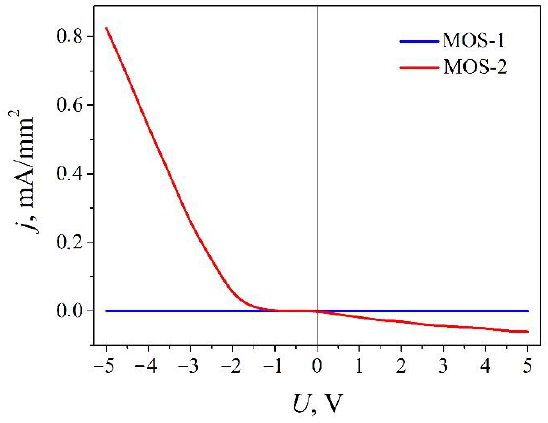
Figure 3. Current-voltage characteristics of the MOS structures. Photocurrent is induced when the MOS structures are exposed to the pulsed CO 2 laser light. In the case of “perfect” MOS-1 sample, photovoltage of negative polarity with respect to the grounded terminal is detected when reverse bias is applied (see measure- ment scheme in Figure 1), and the corresponding photocurrent maximum value increases sharply with the reverse bias and then saturates (Figure 4a, blue solid dots). Much weaker photosignal of opposite polarity (blue open dots) is observed under the forward bias. Typ- ical photocurrent pulse through the MOS-1 sample is shown in Figure 4b. Its dual-polarity shape is similar to an inherent feature of a charging-discharging capacitor. Comparison of curves of MOS-1 in Figures 2 and 4a implies that the photocurrent is most probably related to the capacitance of the structure. The main noteworthy difference in the course of these two dependencies is higher reverse voltage values at which saturation of the C-V charac- teristic begins. Most of the bias voltage applied on the MOS structure falls on the insulator, and the only capacitance that is varied by the voltage is that of the semiconductor surface. To find how C S varies with the applied voltage, we used Equation (1) and data of the C tot - V dependence (Figure 2). The result is depicted in Figure 5 in open orange symbols. For comparison, photocurrent versus the voltage is also shown in the picture. Good agree- ment between the calculated and measured results is seen. ( a )